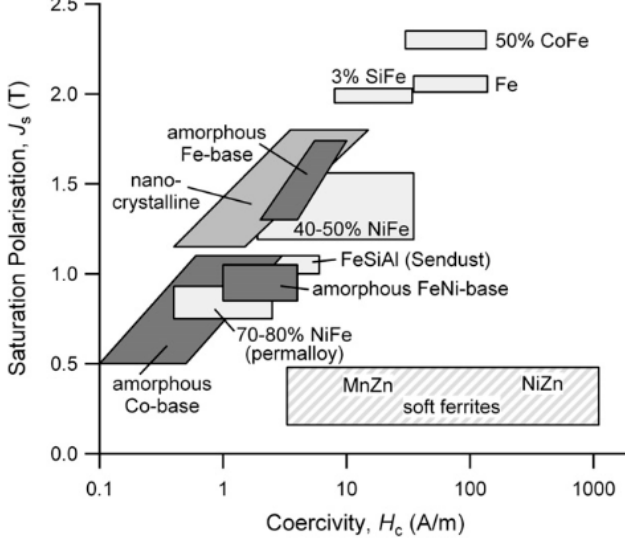
Figure 1. Comparison of the magnetic properties of soft magnetic materials (reprinted with the permission from [23], Elsevier, 2013).